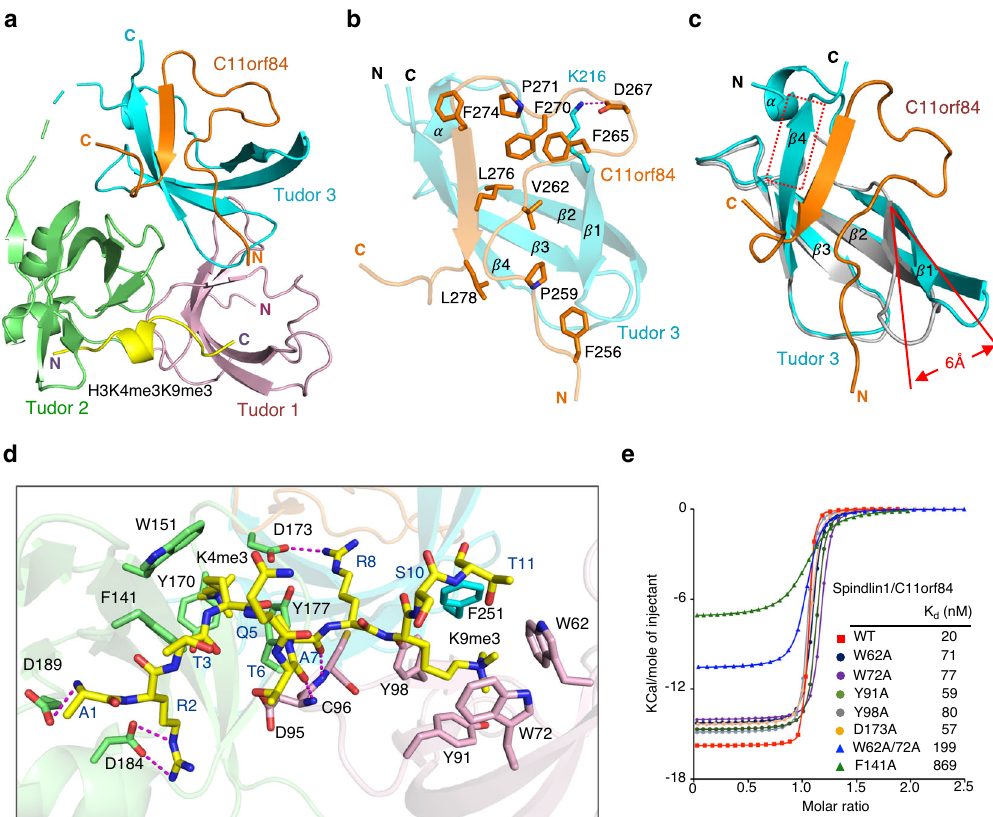
Fig. 2 Structural details of Spindlin1/C11orf84/H3K4me3K9me3 ternary complex. a Cartoon representation of the structure of Spindlin1/C11orf84 bound to H3K4me3K9me3 peptide. Spindlin1 Tudor 1, Tudor 2, and Tudor 3 domains are colored in light pink, green, and cyan, respectively. The C11orf84 segment and H3K4me3K9me3 peptide are colored in orange and yellow, respectively. b Detailed view of the interaction between C11orf84 and Spindlin1 Tudor 3 domain. Key residues involved in the interaction are depicted as stick models and labeled. Hydrogen bonds and salt bridges are shown in magenta dashed lines. c Structural comparison with the previous determined Spindlin1/H3K4me3R8me2a binary complex (PDB: 4MZF, colored in light gray) revealed that binding of C11orf84 fragment induced conformational changes in Spindlin1 Tudor 3 domain. The red dash box highlights the Y256-K260 segment of Tudor 3 adopts a β -strand conformation upon C11orf84 binding. In addition, the Tudor 3 β 1 – loop – β 2 region was pushed outward with ~6 Å in distance to accommodate the C11orf84 fragment. d The detailed interaction network of Spindlin1/C11orf84 with H3K4me3K9me3 peptide. The H3K4me3K9me3 segment is depicted as yellow sticks. Hydrogen bonds and salt bridges are shown in magenta dashes. e ITC fi tting curves for binding of Spindlin1/C11orf84 complex including Spindlin1 wild type and mutants to the H3K4me3K9me3 peptide, along with the calculated K d . The thermodynamic parameters are listed in Supplementary Table